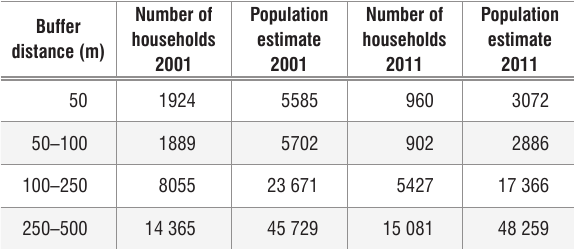
Table 4: Households and residential areas very close to tailings storage facilities during 2001 and 2011, with estimates of population for the City of Johannesburg Buffer distance